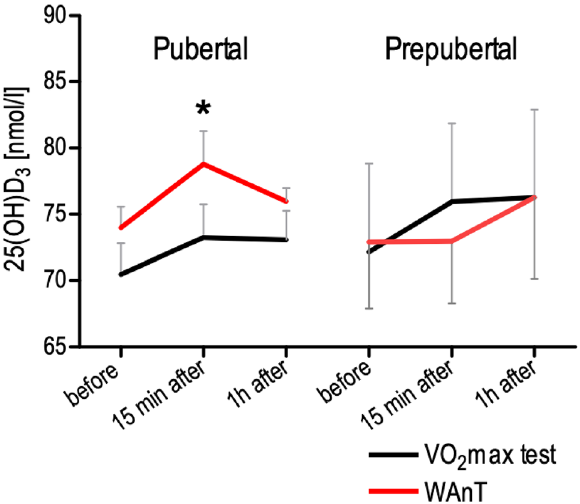
Figure 2. The concentration of 25(OH)D3 before, 15 min after and 1 h after a single bout of exercise in pubertal (n = 7 for VO 2max test, and n = 7 for WAnT test) and prepubertal (n = 5 for VO 2max test, and n = 7 for WAnT test) boys according to two types of exercise (VO 2 max and WAnT tests). *p = 0.032—difference between indicated result/mean and the results before in the same group and test, LSD post hoc test after repeated measures